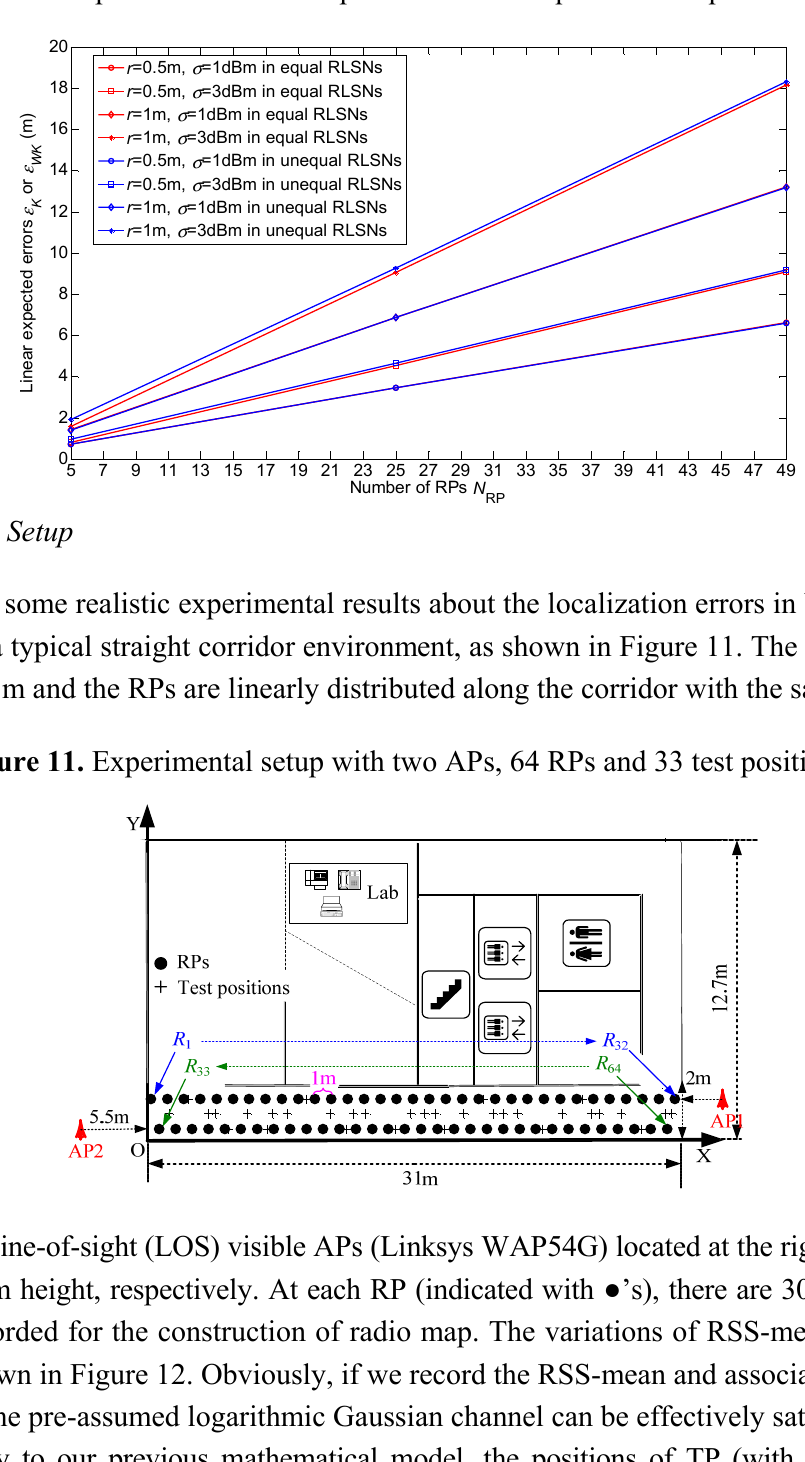
Figure 10. Error comparisons of linear expected errors in equal and unequal-weighted RLSNs.